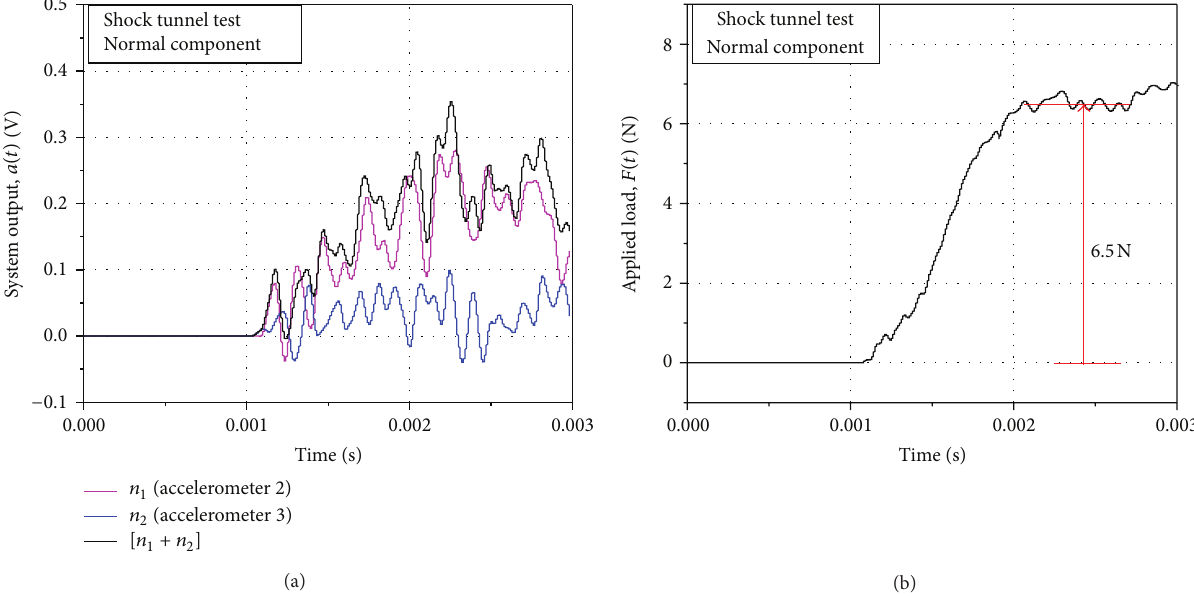
n 1 (accelerometer 2)